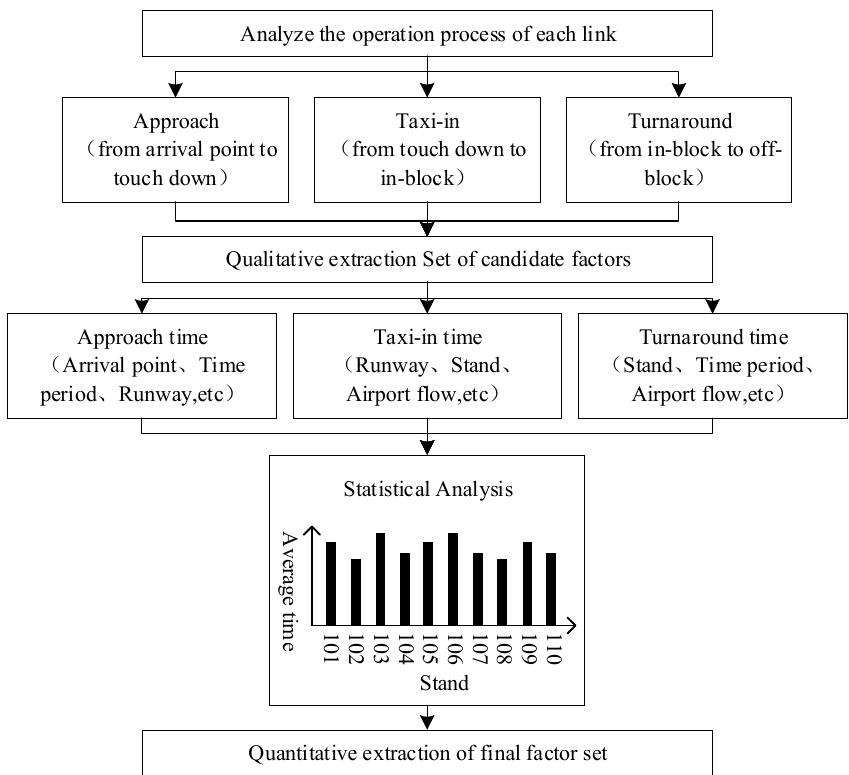
Figure 6. Influencing factors extraction method and steps.